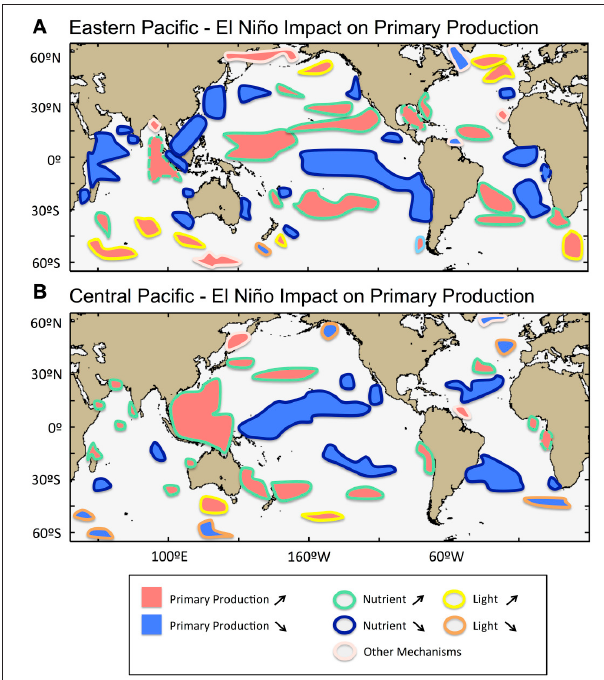
FIGURE 6 | Schematic atlas of the influence of El Niño variability on oceanic phytoplankton in the global oceans. (A) Eastern Pacific El Niño influence, and (B) Central Pacific El Niño influence. Increase and decrease in primary production (PP) are indicated in red and blue filled colors respectively. The color contours provide information about the controlling biophysical mechanisms (which are described in Section Physical Forcing Mechanisms Associated with El Niño Variability and Mapped in Figure 3 ): (yellow) PP is nutrient-limited; (dark blue) PP is enhanced by nutrient availability; (orange) PP is light-limited; (turquoise) PP is enhanced by light availability; (light pink or dashed contour) PP may be further controlled by other mechanisms, such as sea-ice melting, atmospheric dust deposition and availability of trace nutrients. The contour delineation of the influence of EP and CP El Niño is generated based on information displayed in Figure 2 and Supplementary Figure